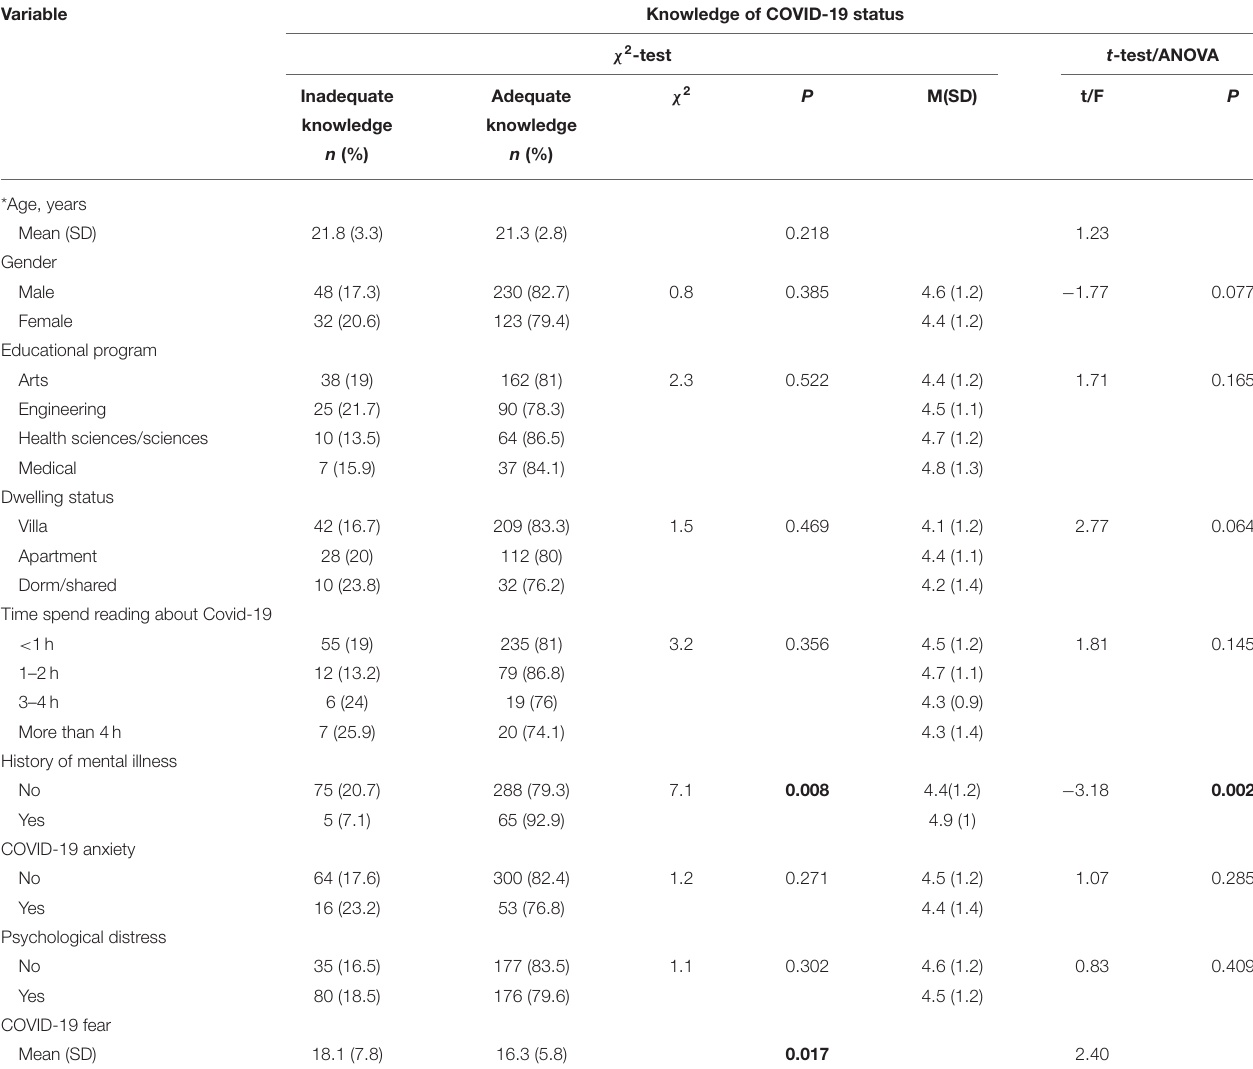
TABLE 2 | Association and differences between knowledge and demographic variables, psychological distress, anxiety, fear. Variable Knowledge of COVID-19